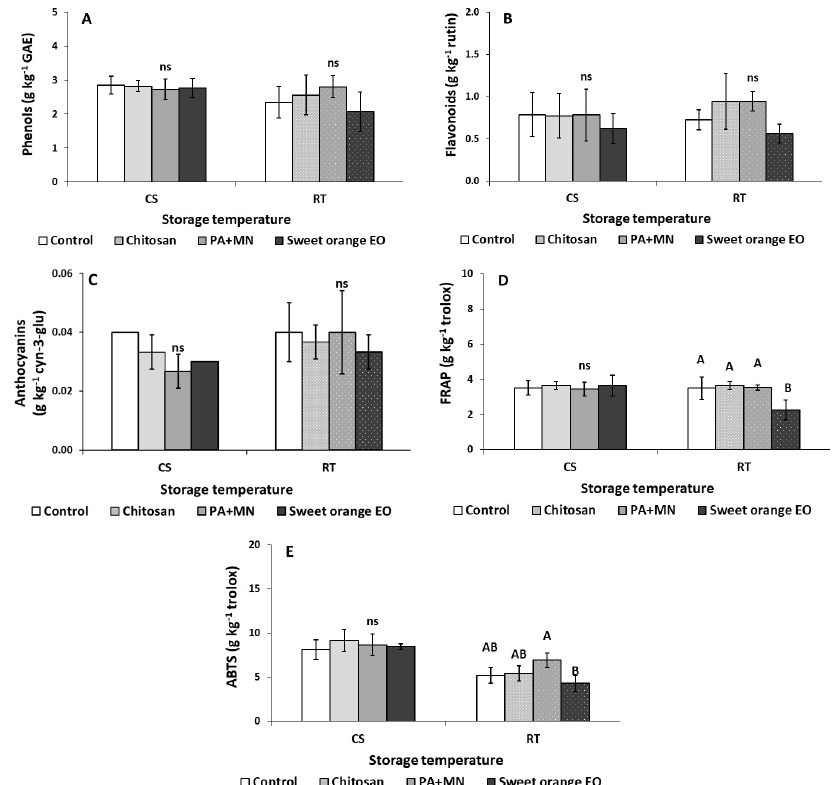
Figure 3. Effect of chitosan, phosphoric acid plus micronutrients (PA+MN), and sweet orange EO treatment on ( A ) firmness, ( B ) total soluble solids (TSS), ( C ) total acidity (TA), and ( D ) ascorbic acid (AA) of strawberry fruit after three days of storage at RT (20 °C) and CS (4 °C). Error bars represent the standard deviation of the mean of (three/six fruit) replicates. Treatments indicated with different letters for each storage condition differed significantly (Tukey’s honestly significant difference, at p ≤ 0.05); ns: not significant.